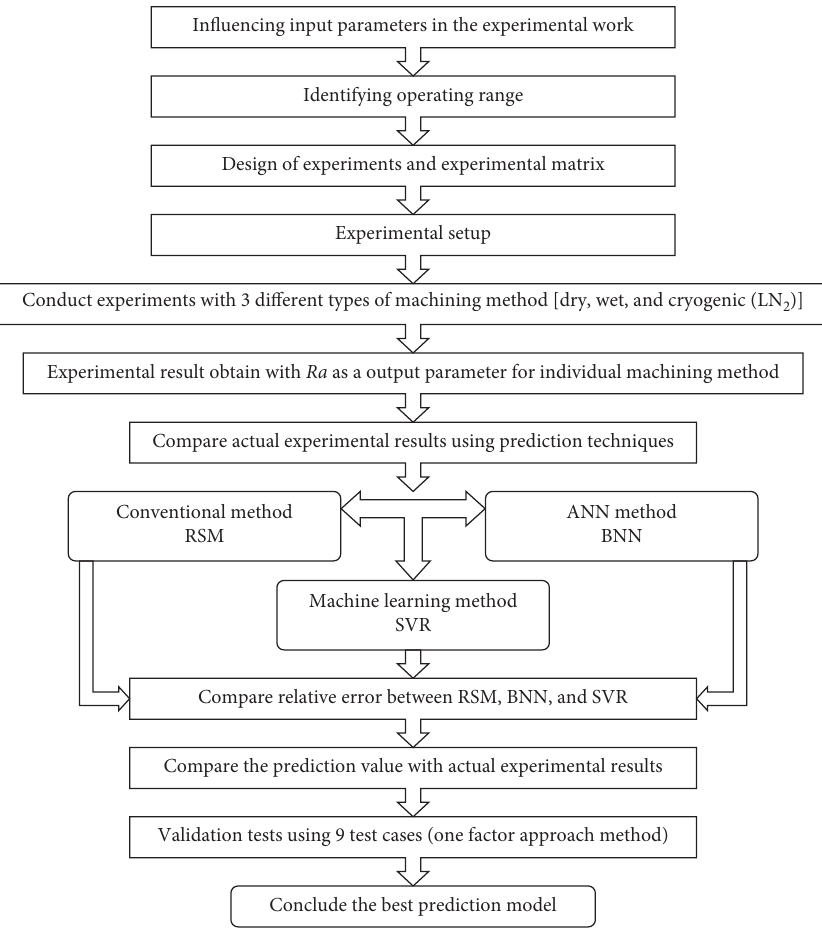
Figure 1: Research